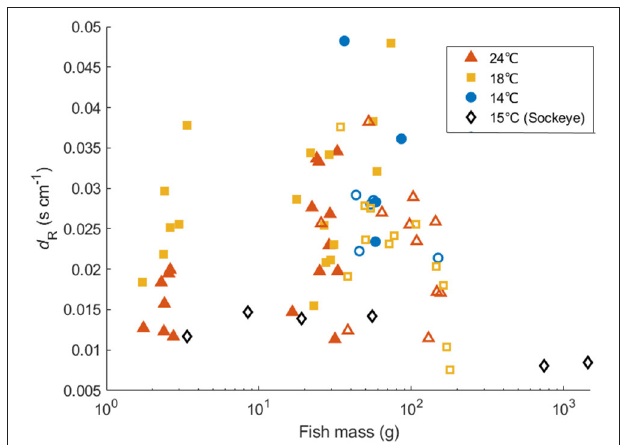
FIGURE 8 | Comparison of the relationship between fish mass and d R among Pacific chub mackerel from the Northwest (solid markers) and Northeast (open markers) stocks in comparison to sockeye salmon ( Oncorhynchus nerka , black diamonds) derived from Brett